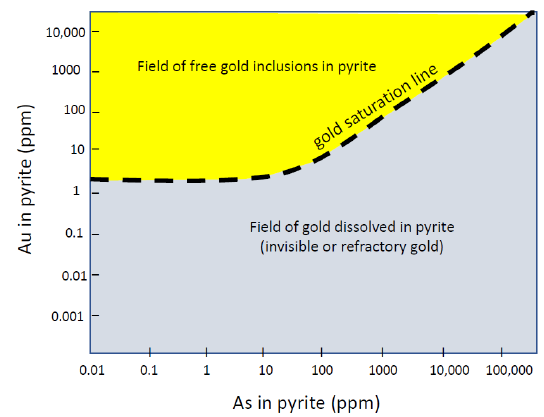
Figure 1. Au-As association in pyrite [4]. Data plotting below the gold saturation line (grey area) represents invisible gold dissolved in pyrite. Above the line (yellow area) gold is present as nano- to micro-gold inclusions in pyrite.